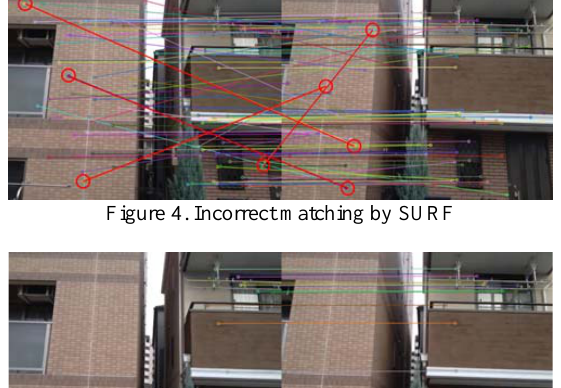
Figure 5. Correction of matching results by